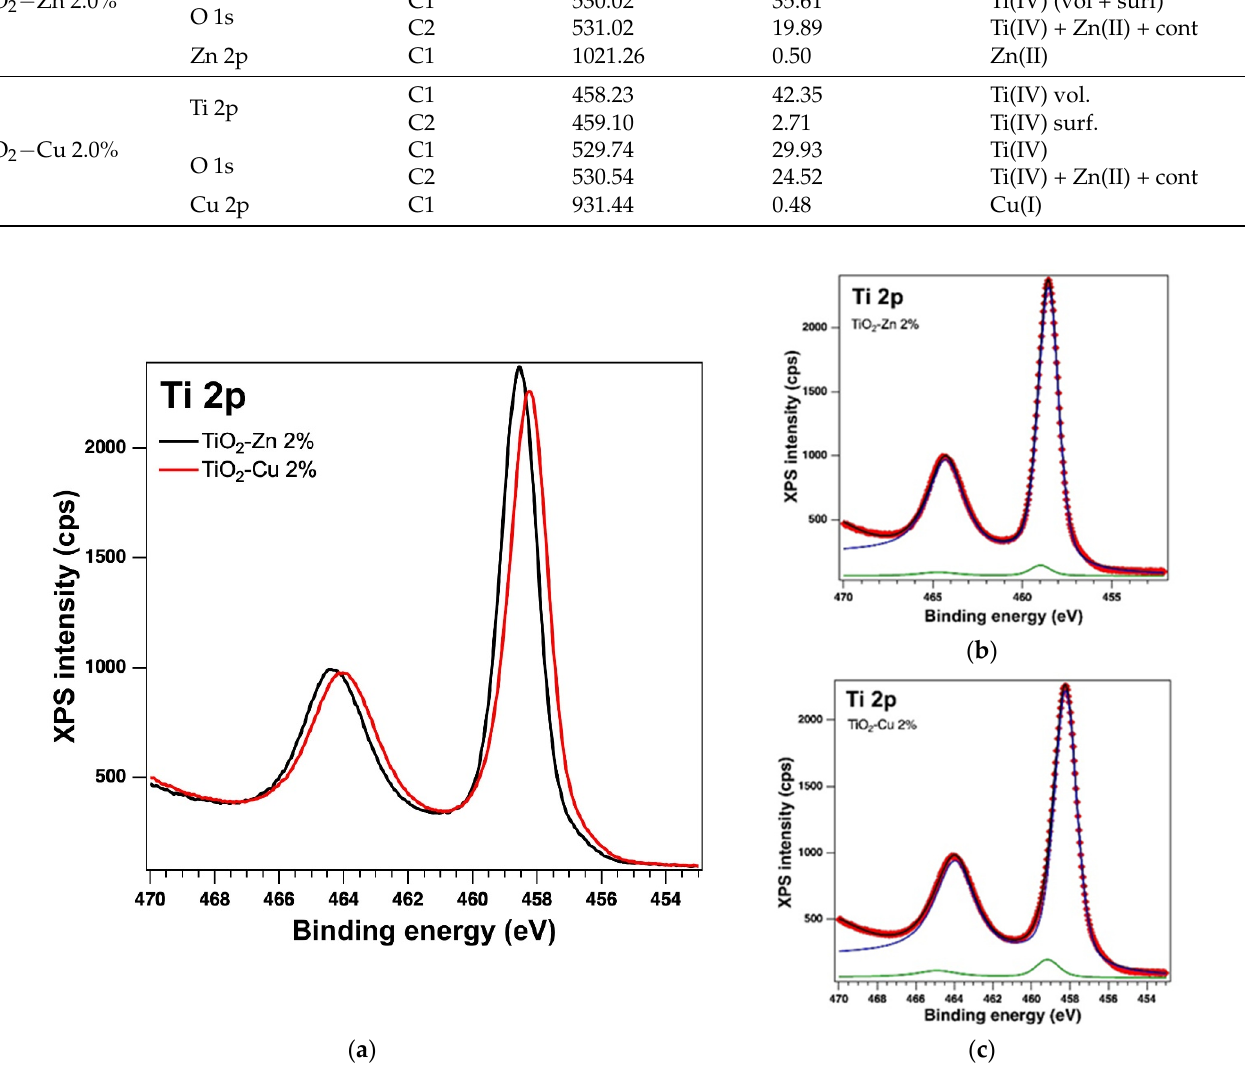
( c ) Figure 6. XPS spectra of the core level O 1s ( a ) overlayed XPS spectra of the samples prepared by the sol − gel method and the experimental data (red symbols) with the fi t and deconvolutions given